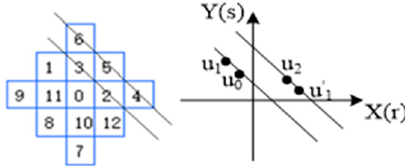
Figure 4. Number sequence on line y = − x + a.